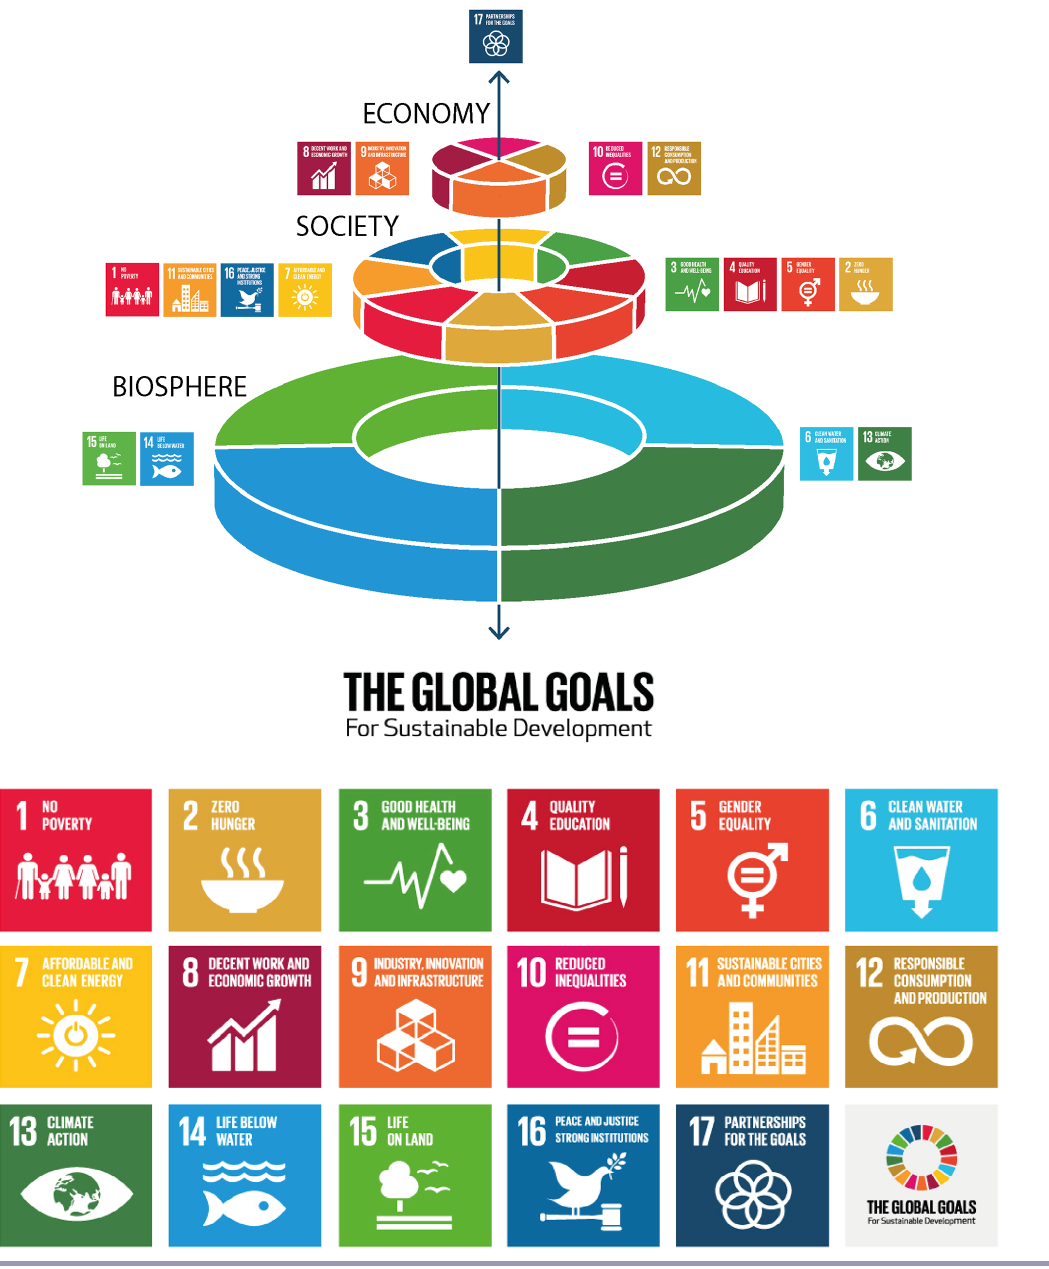
Fig. 4 . The 17 Sustainable Development Goals positioned in relation to the biosphere foundation and the safe operating space for humans on Earth. Redrawn from Rockström and Sukhdev (2014) as presented at the 2016 EAT Forum (http://eatforum.org/event/eat-stockholm-food-forum-2016/#program). The global goals logo and icons are from the Global Goals (http://www.globalgoals.org/#the-goals), see also the Sustainable Development Knowledge Platform of United Nations (https://sustainabledevelopment.un.